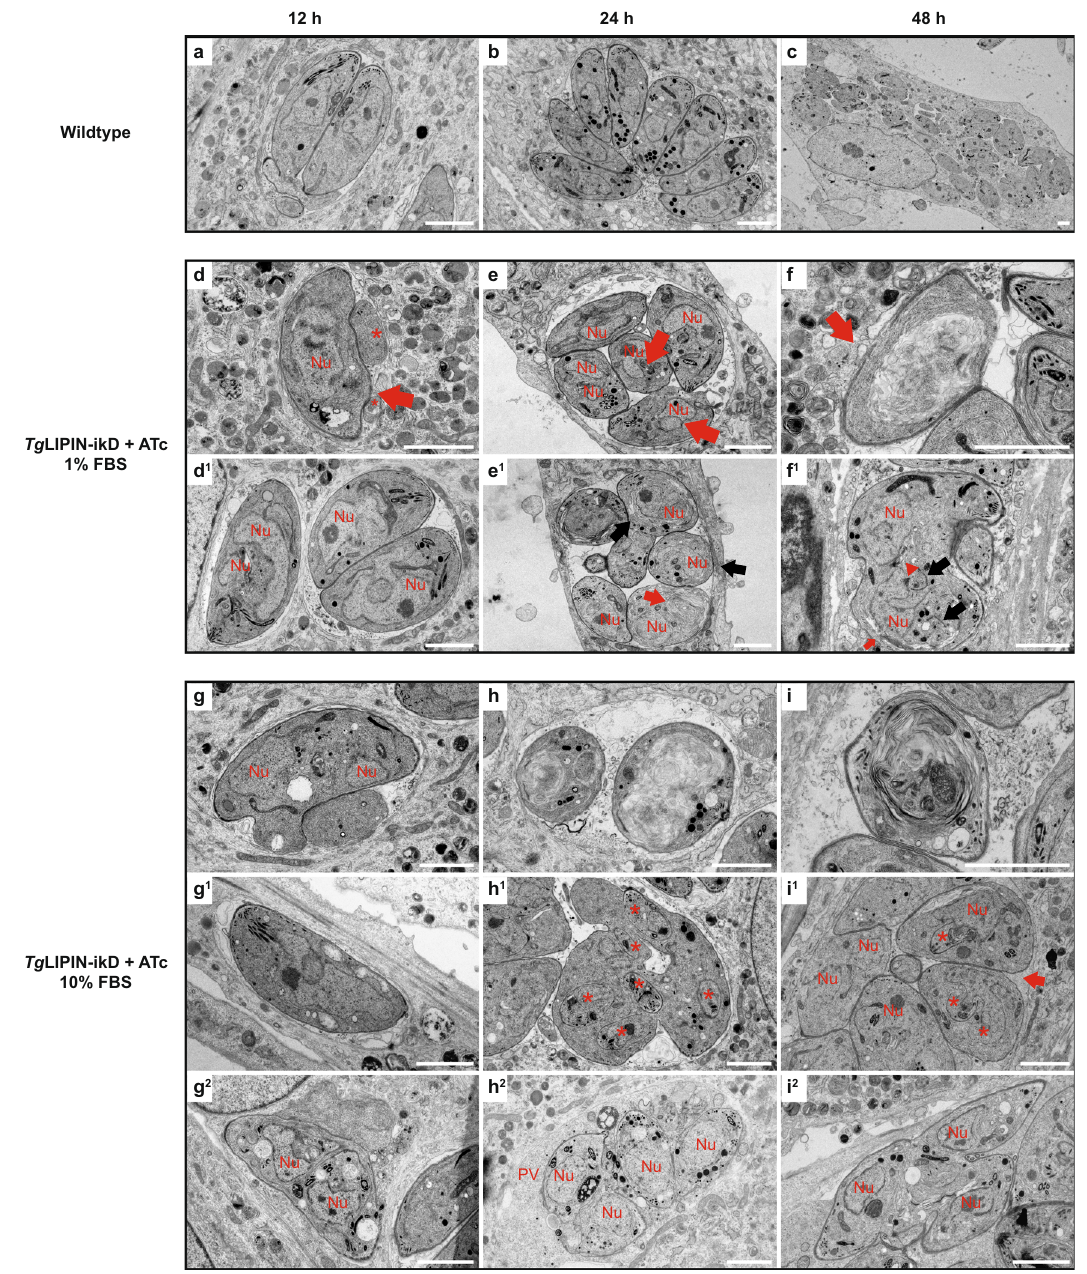
Fig. 3 Tg LIPIN depletion results in gross membrane anomalies early in the process of ATc downregulation. Transmission electron micrographs showing wild-type ( a – c ) and Tg LIPIN-ikD parasites at 1% ( d – f ) or 10% FBS ( g – i ), after 12, 24, and 48 h of ATc treatment. After 12 h of growth, wild-type parasites showed vacuoles containing ( a ) 2 – 4 parasites, ( b ) 8 – 16 parasites at 24 h, and ( c ) after 48 h, the fi rst round of egress/reinvasion has occurred